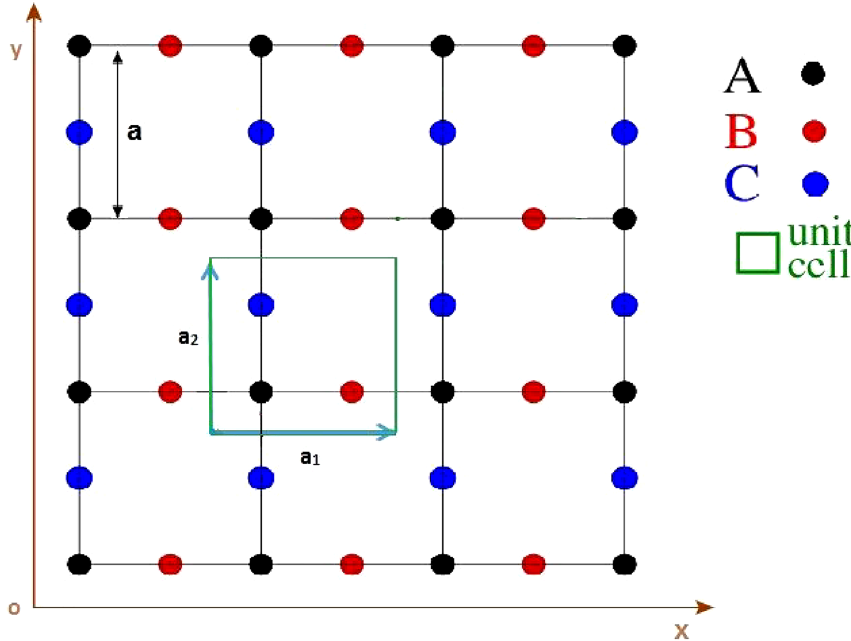
Figure 1. Lieb lattice showing three-site basis in unit cell, with unit cell vectors a 1 , a 2